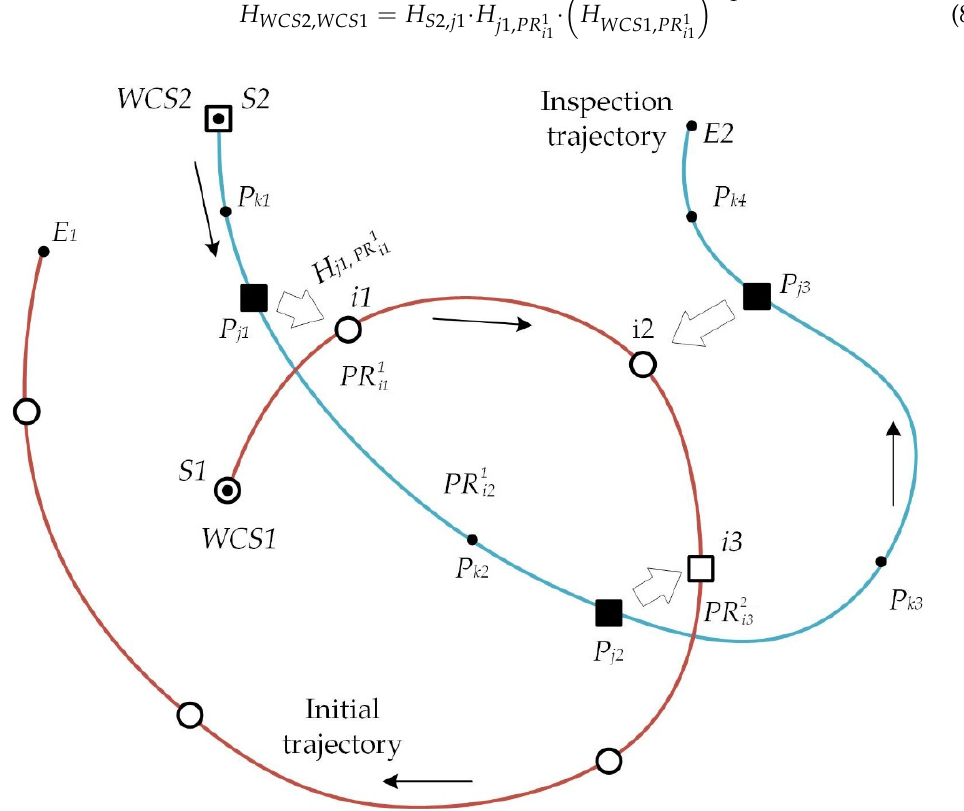
Figure 7. Calculation of inspection trajectory using virtual points of VCRN (starting points S1 and S2 are not close). White circles and squares are reference points of VCRN. The black squares indicate the positions on the inspection trajectory where the binding to the reference points of VCRN is